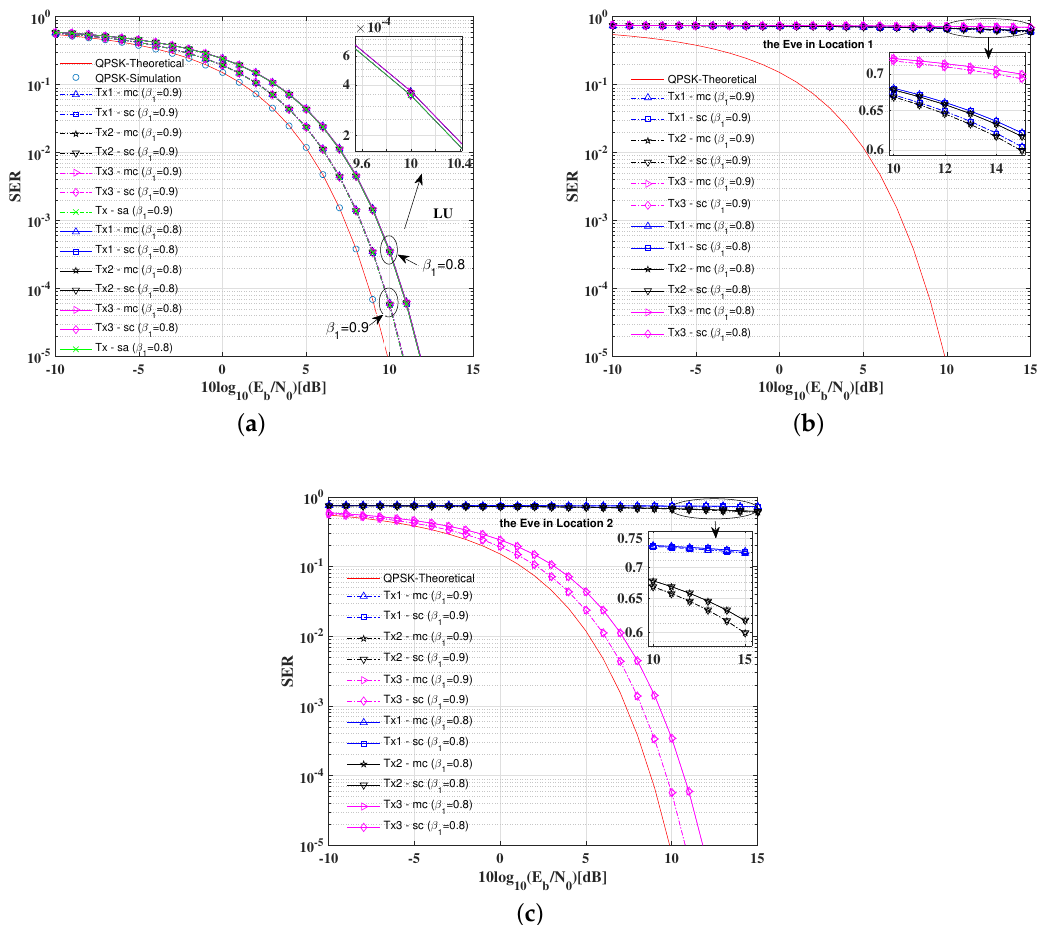
Figure 8. SER performance versus SNR per bit (dB) with various power allocation factors for the proposed DM schemes and the conventional DM scheme: ( a ) the LU; ( b ) the Eve in Location 1; and ( c ) the Eve in Location